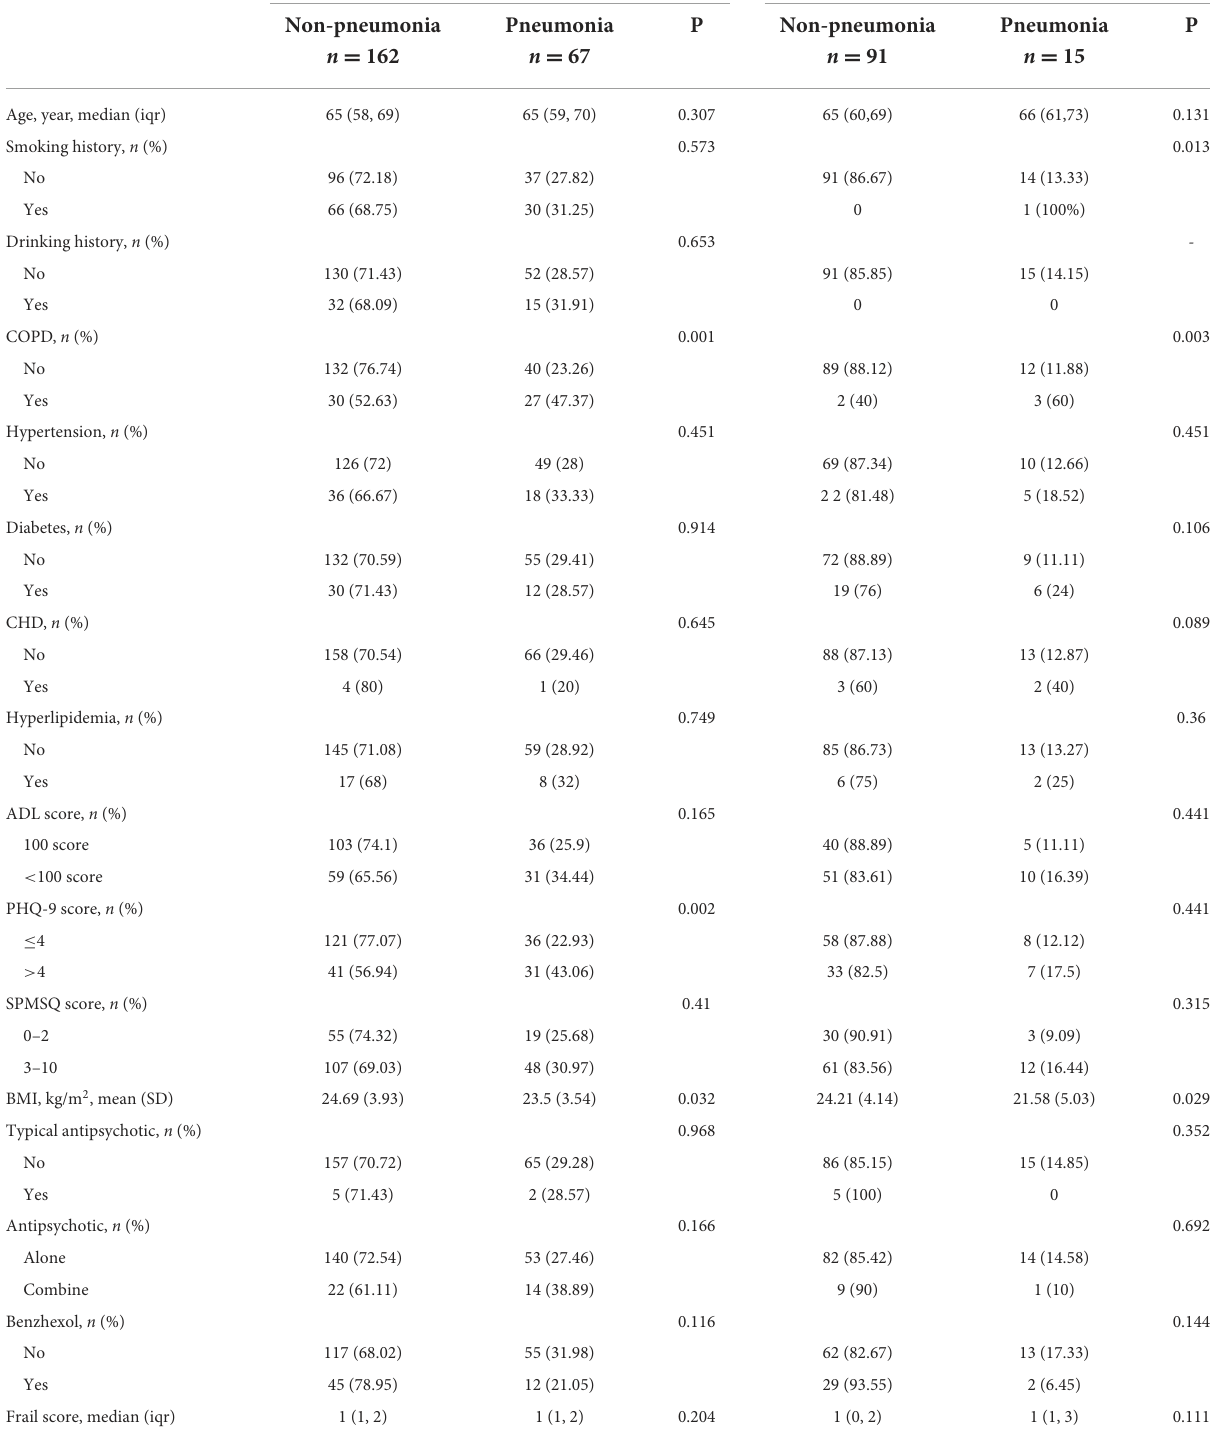
TABLE 1 Characteristics of the